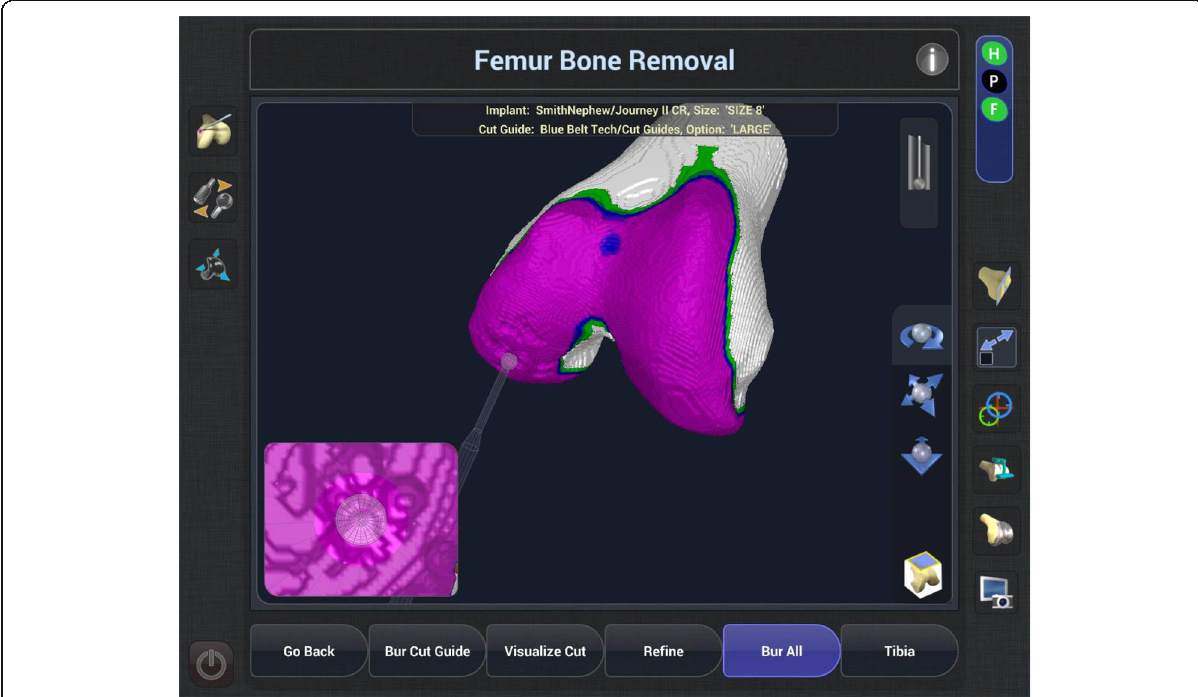
Fig. 4 Screen shot from the NAVIO (Smith and Nephew) console of robotically-assisted TKA demonstrating the ‘ planning page ’ . RTKA systems allow surgeons to modify implant position and size to achieve a desired plan. The planning page gives feedback to the surgeon about the effect of the adjustments on gap